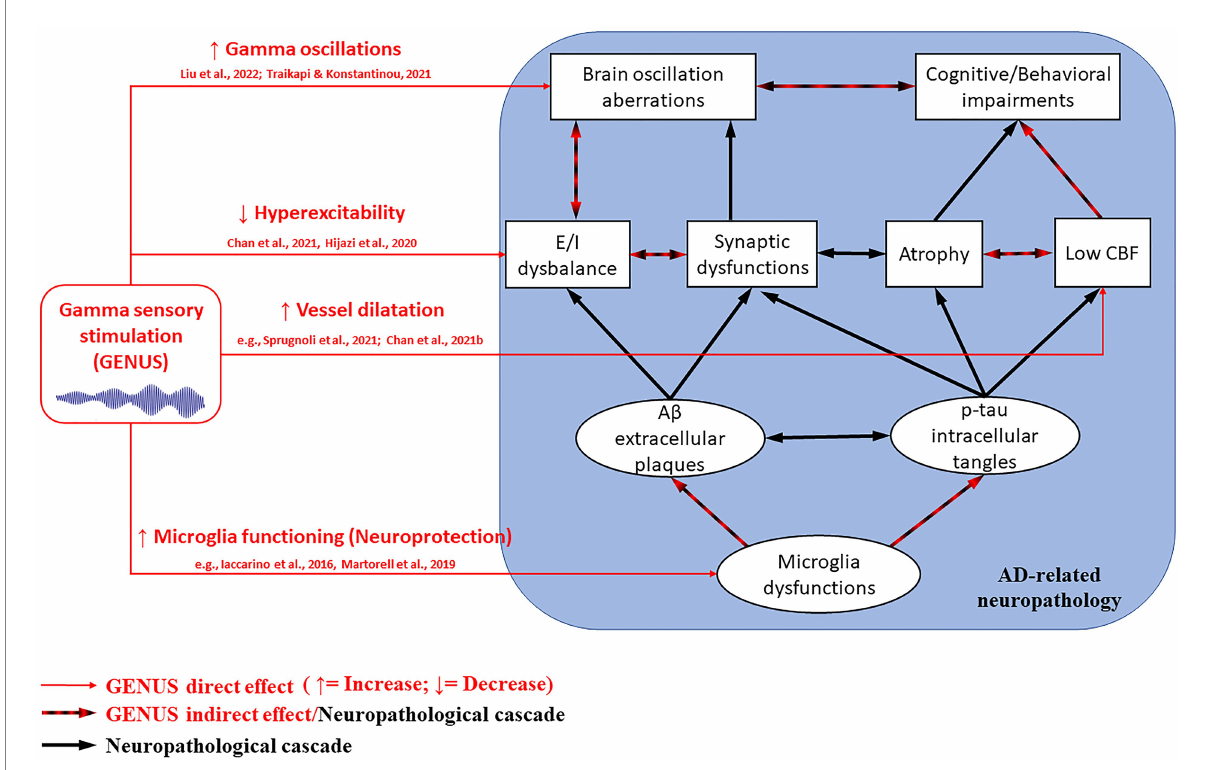
FIGURE 1 GENUS mechanisms on the AD-related neuropathological cascade (within the blue square). GENUS can directly affect (red arrows) gamma oscillations, excitatory/inhibitory (E/I) balance, cerebral blood flow (CBF), and morpho-functional properties of microglia. In turn, such improvements can indirectly impact (black and red arrows) brain atrophy process, amyloid-beta (A β ) plaques, and neurofibrillary phosphorylated- tau (p-tau) tangles formation, thus cognitive and behavioral manifestations. The strongest effects derive from combining visual and auditory stimulation, rather than using a single